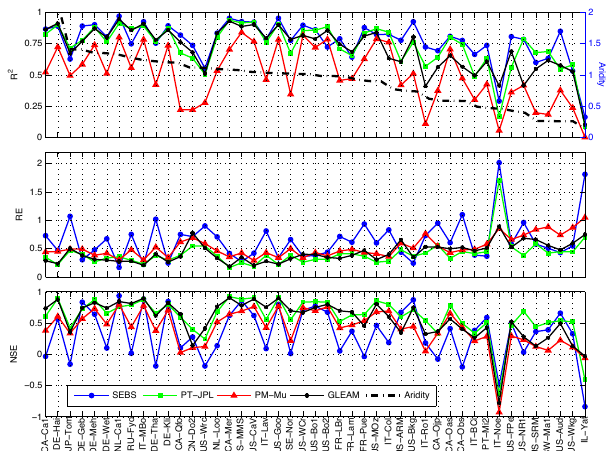
Figure 4. Comparison of the performance skill of the models in reproducing evaporation for the tower-based analyses. R 2 is the coefficient of determination, RE is relative error (lower is better) and NSE is the Nash–Sutcliffe efficiency (higher is better). Towers are arranged from left to right based on an aridity index (secondary y